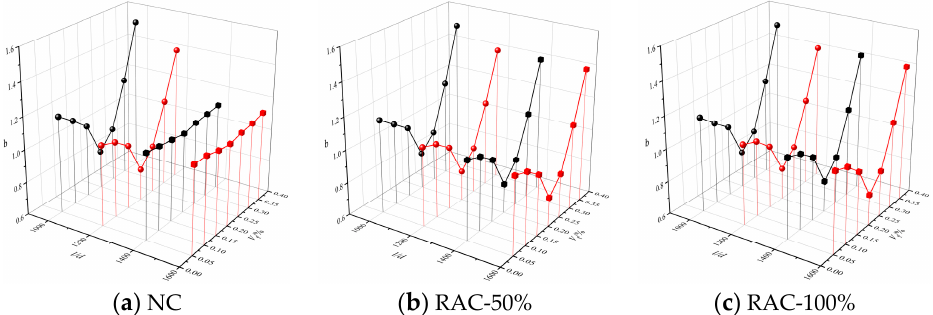
Figure 20. b -value change curve of BFRAC. Table 7. The fitting equation between b and F .